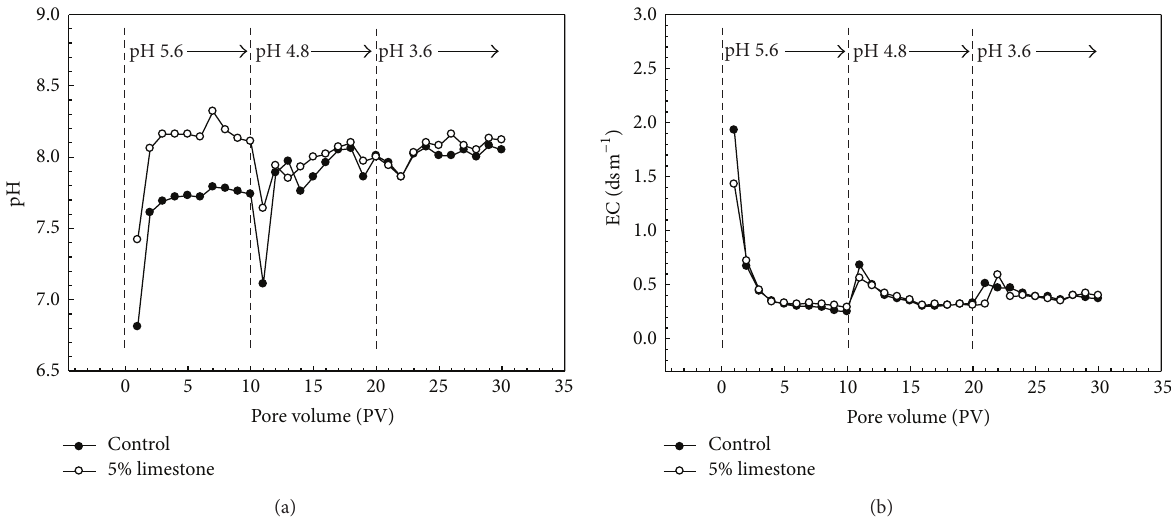
Figure 2: Variation of the (a) pH and (b) EC values of the leachates from the soil columns.